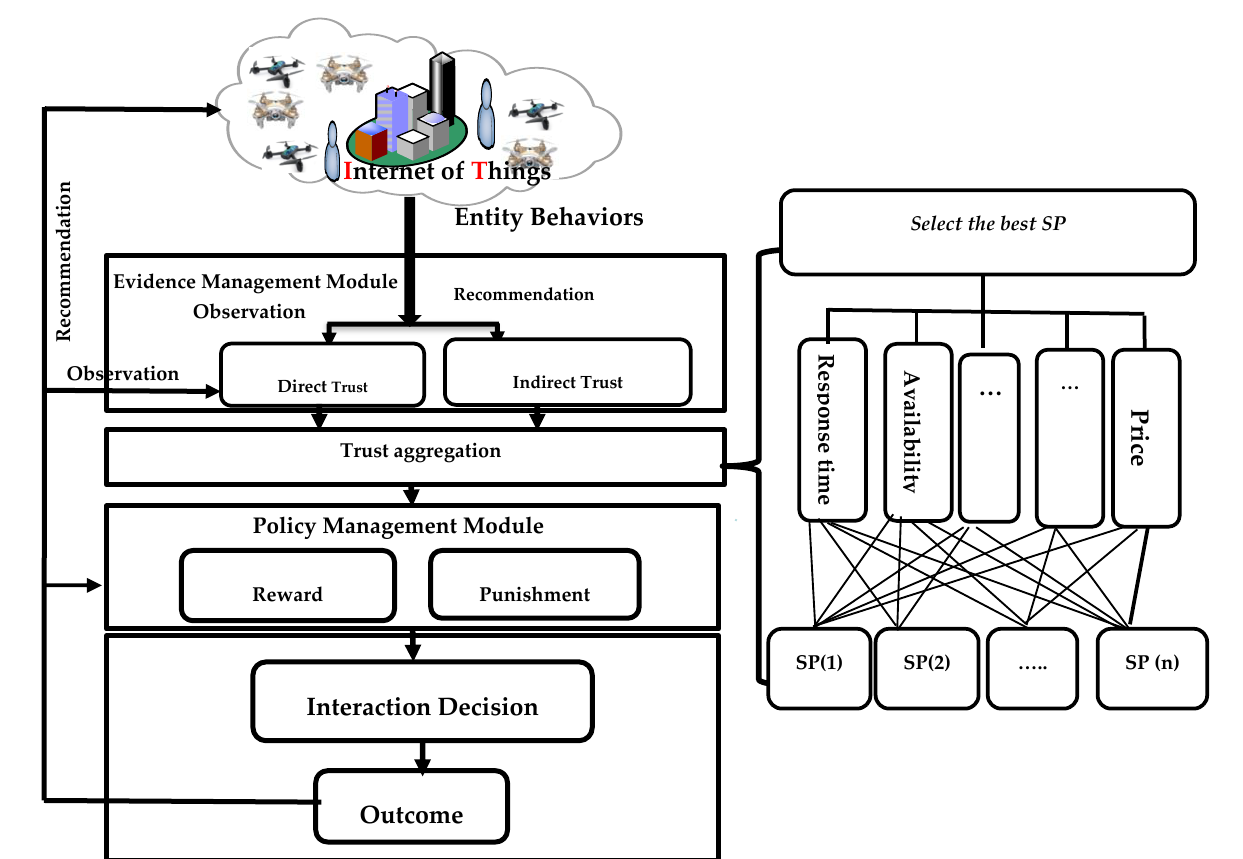
Figure 1. The modules of trust system for trust-based IoT.